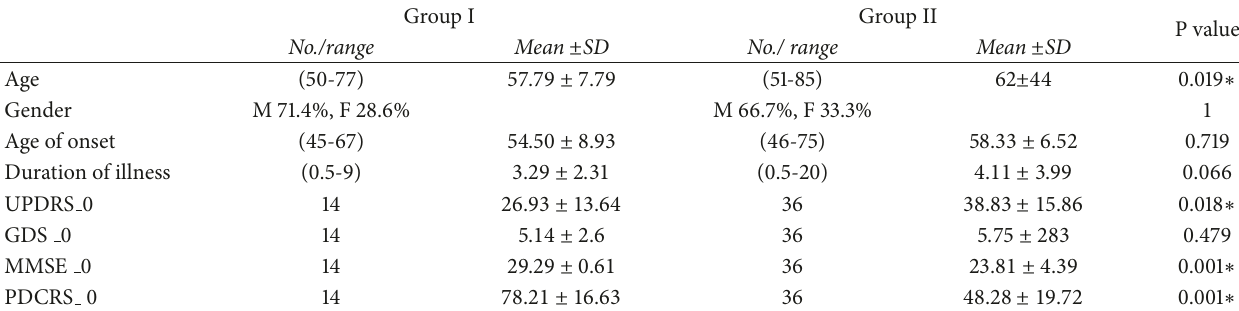
Table 1: Demographic data and baseline characteristics of the study population.